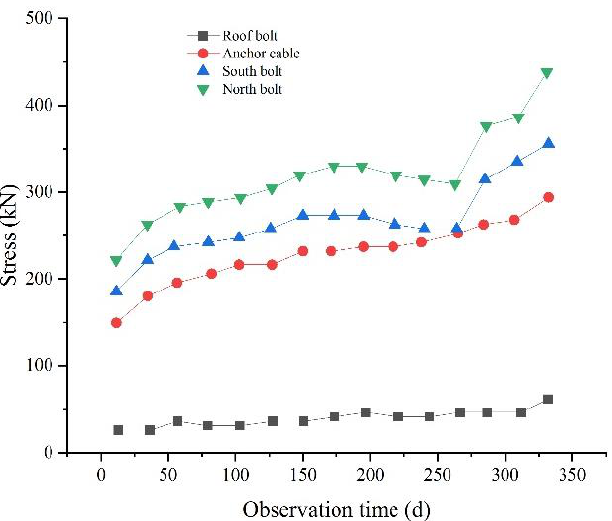
Figure 12. Variation trend of the stress borne by the anchor bolt (cable) in the second group of ergometers in the conveyor roadway of the 360,805 working face.